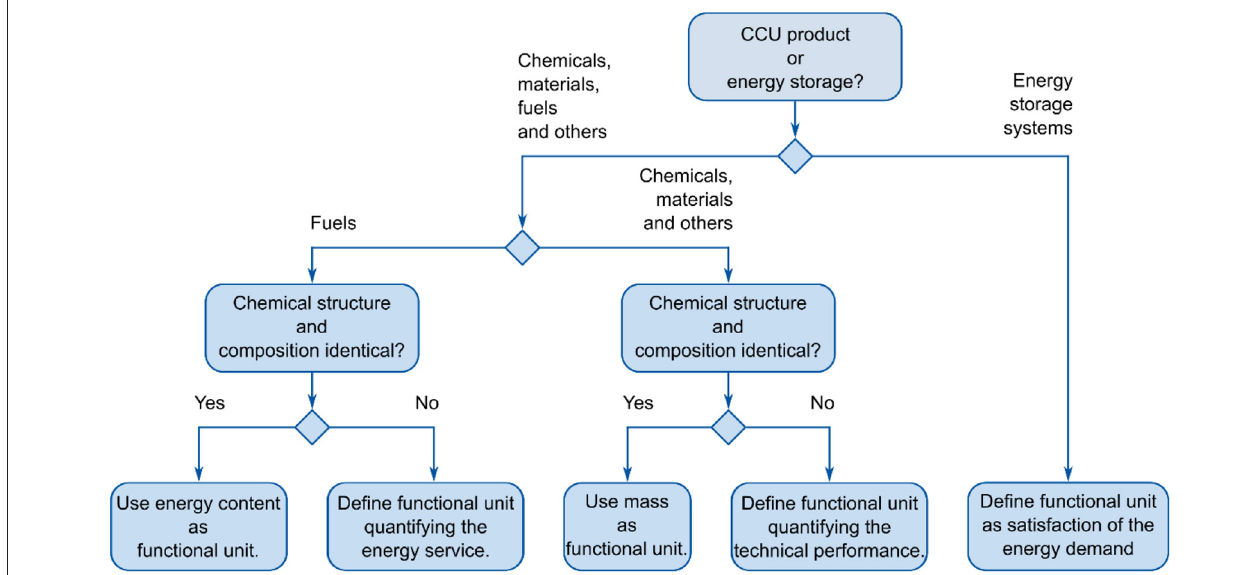
FIGURE 4 | Decision tree for the selection of a suitable functional unit.